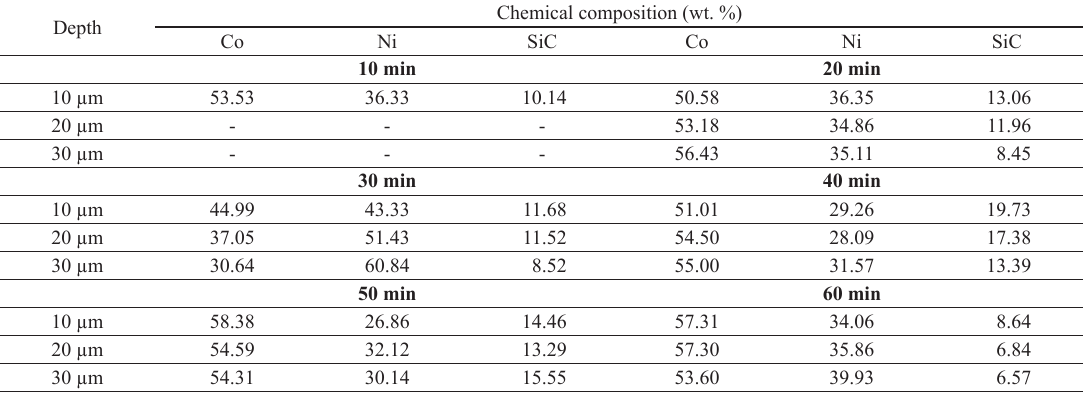
Table 3. Composition of the cross-section of the coatings according to the distance from the surface.